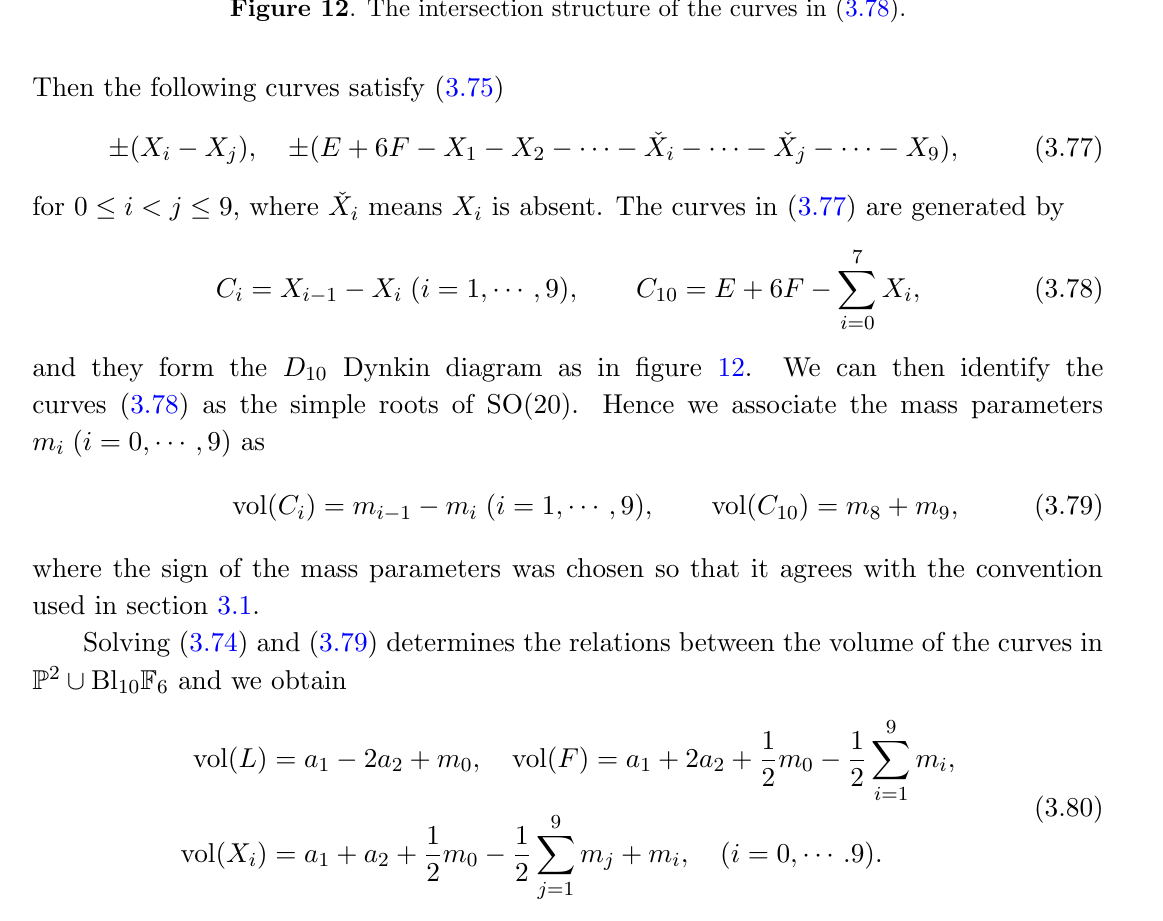
Figure 12 . The intersection structure of the curves in